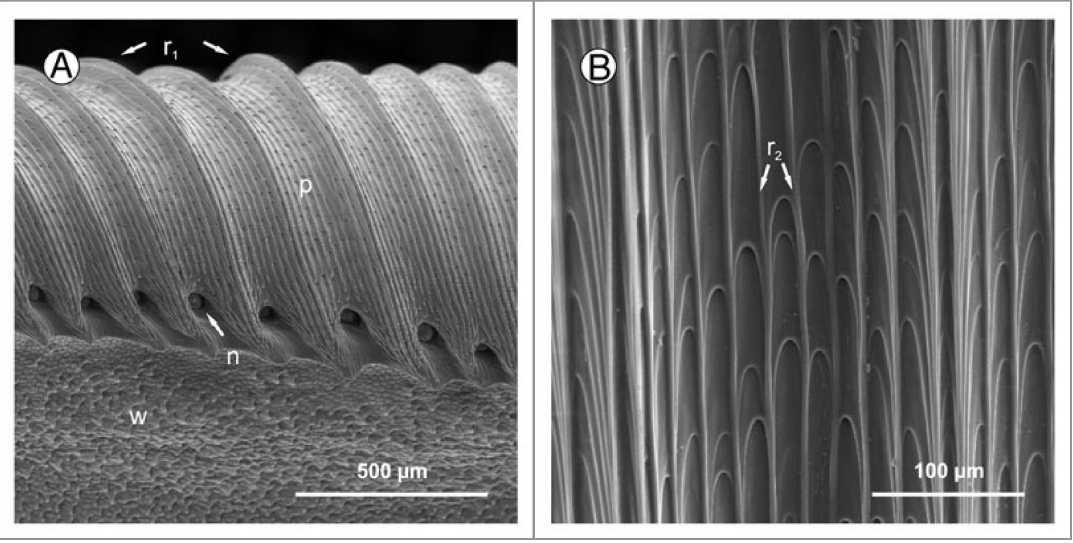
) and 1 ) are formed by straight 2